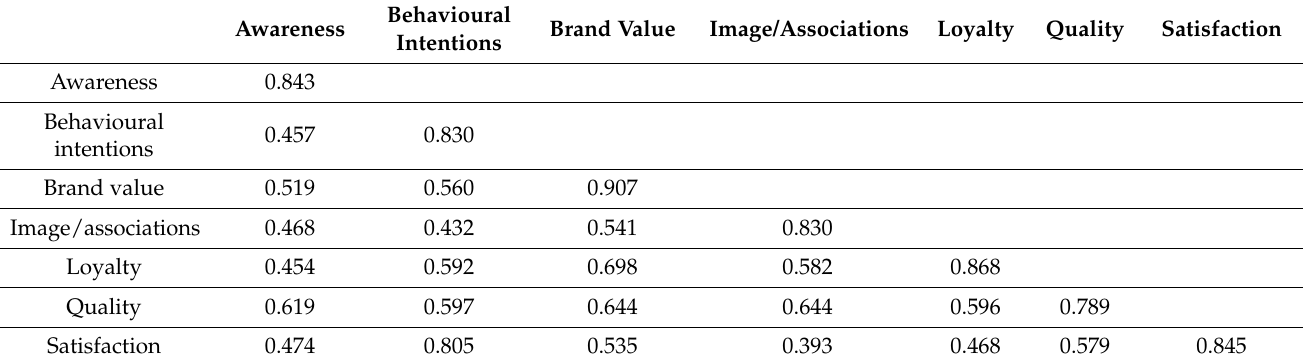
Table 4. Discriminant validity (Fornell and Larcker criterion).